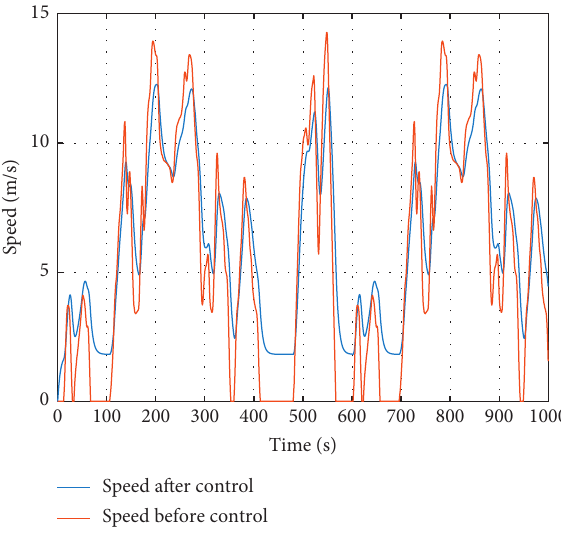
Figure 11: Optimized speed